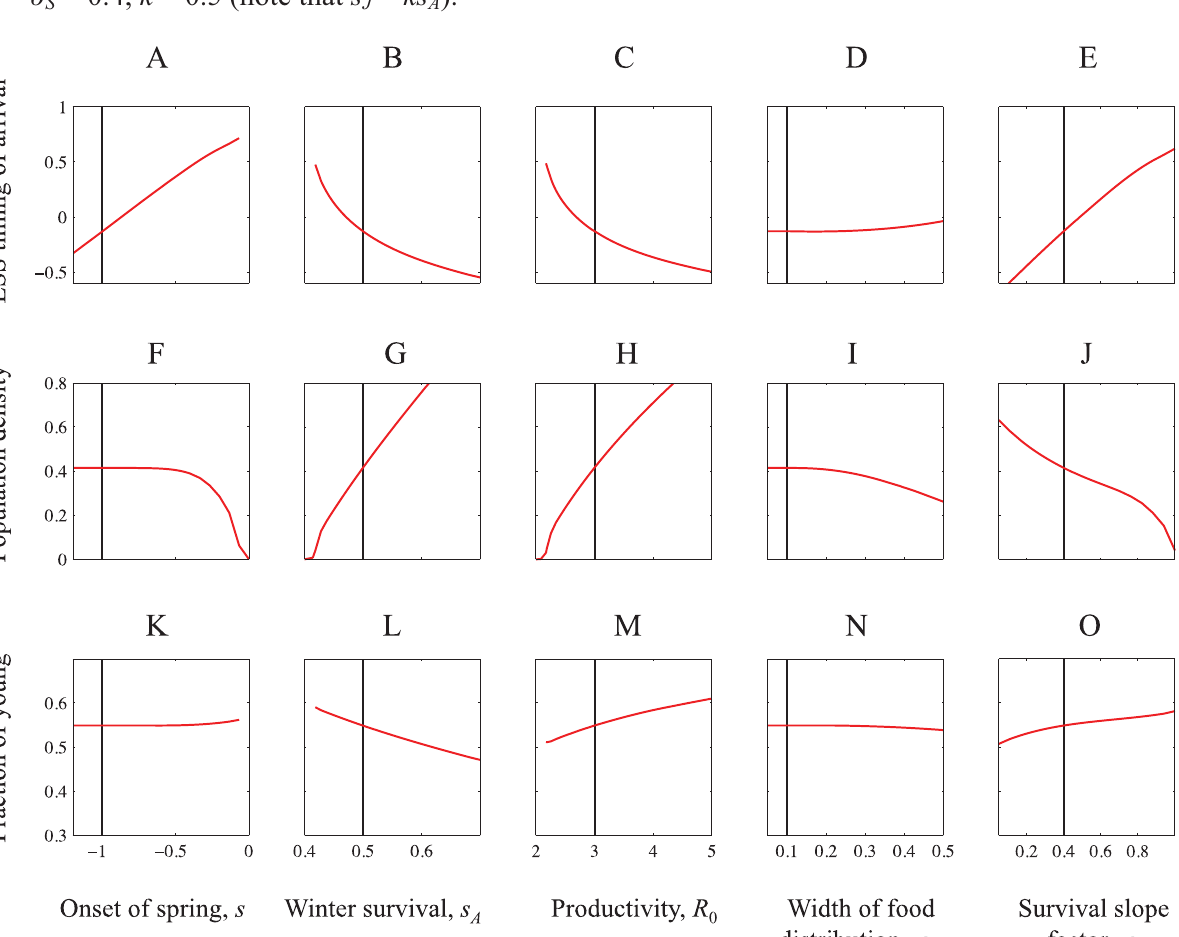
= 0.5, R = 3 A 0 = 1, q = 1, v = 0.5, 0 c